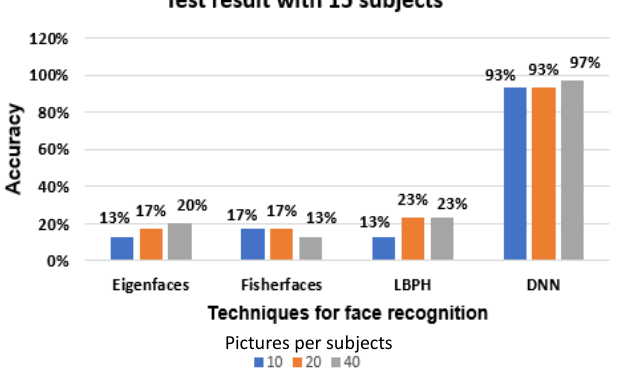
Fig. 4. Methods for face recognition